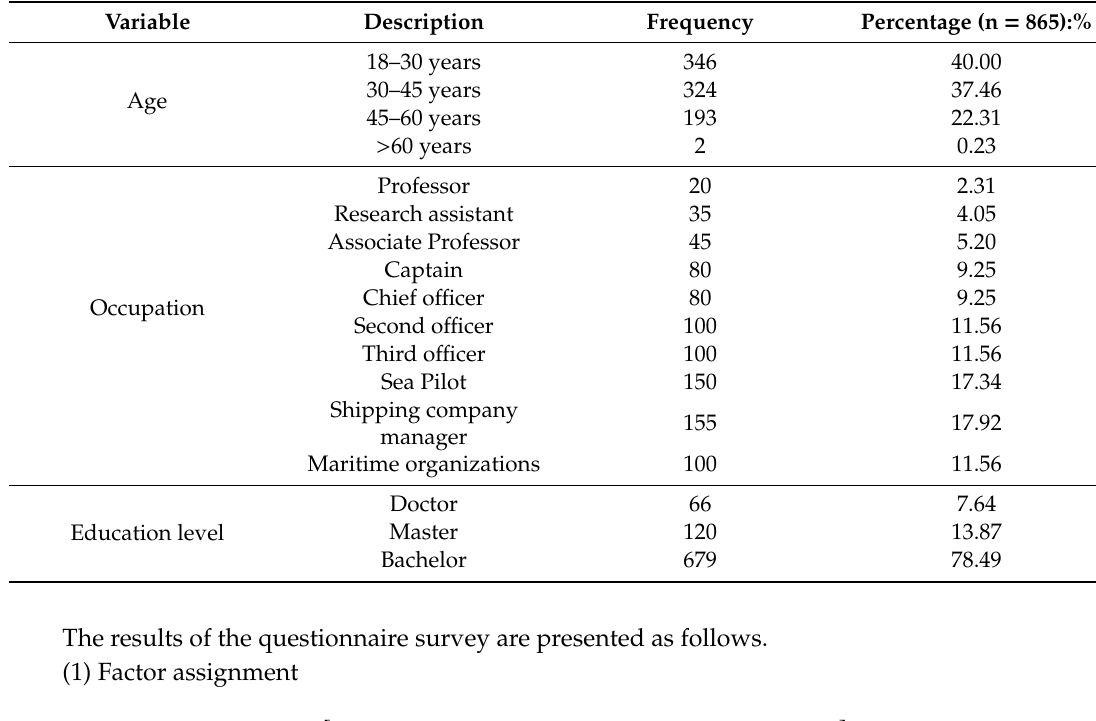
Table 2. Demographic data of experts